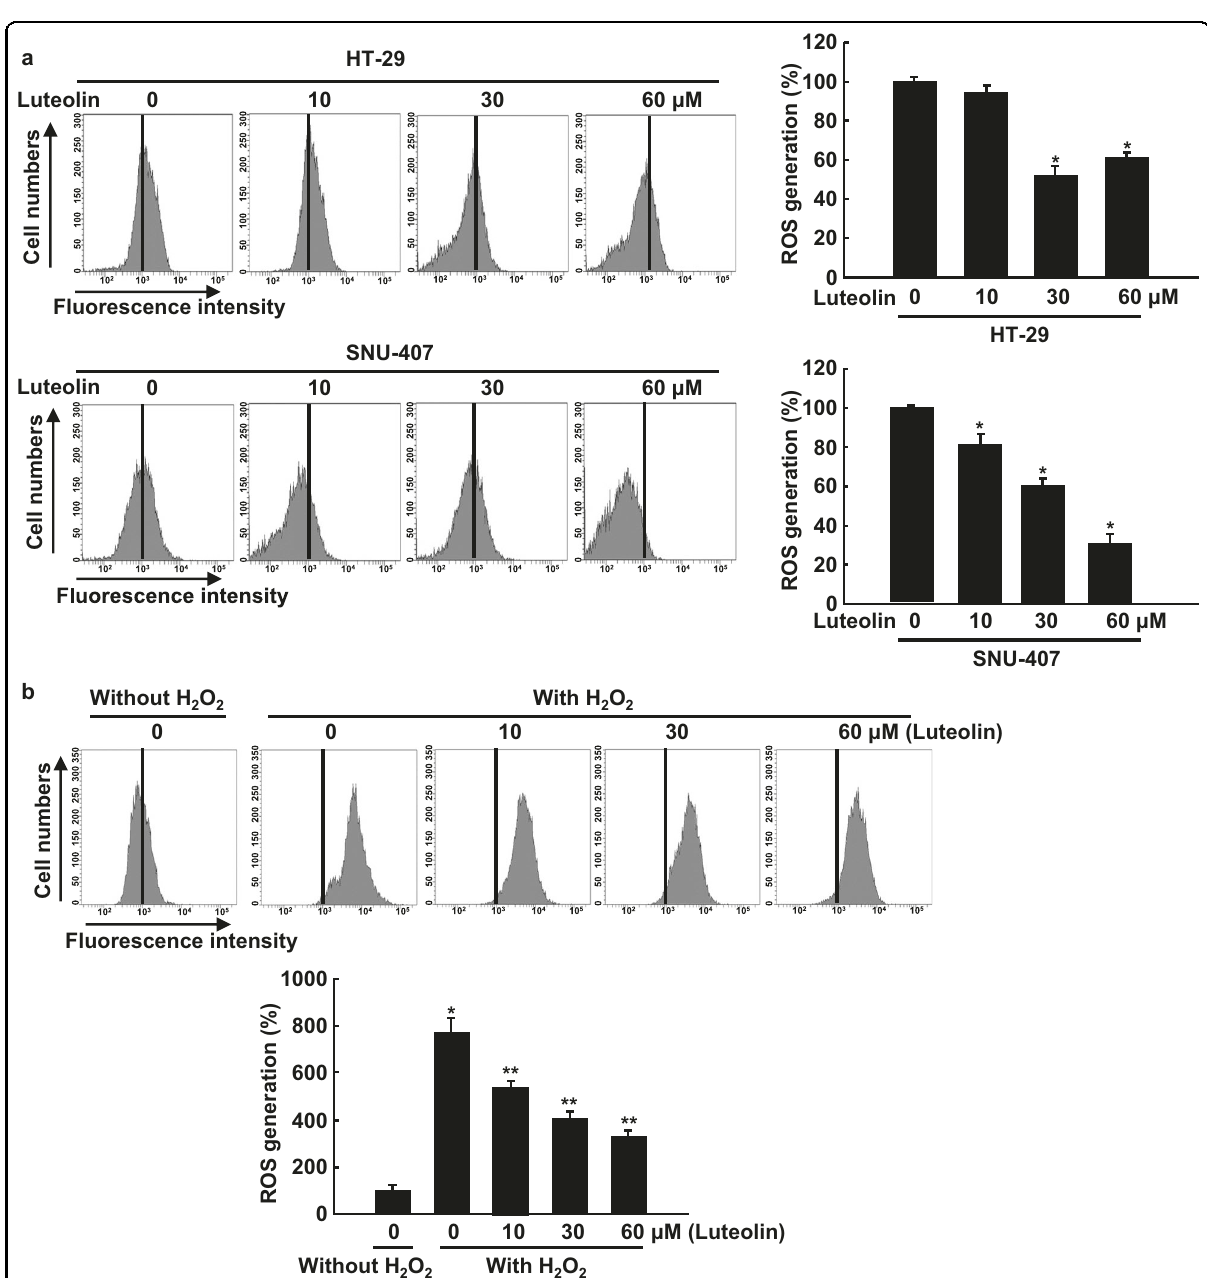
Fig. 2 Luteolin promotes ROS scavenging in colon cancer cells by increasing the expression of antioxidant enzymes. a Cells were treated with various concentrations (0 – 60 μ M) of luteolin for 24 h, and intracellular ROS were detected using fl ow cytometry after DCF-DA staining; * p < 0.05 compared with control cells. b Cells were pre-treated with various concentrations (0 – 60 μ M) of luteolin for 1 h followed by 80 μ M H 2 O 2 for 24 h. Intracellular ROS were detected using fl ow cytometry after DCF-DA staining; * p < 0.05 compared with control cells; ** p < 0.05 compared with H 2 O 2 - treated cells. Cells were treated with c , e various concentrations (0 – 60 μ M) of luteolin for 48 h or d , f 30 μ M luteolin for various durations. Western blot analysis was performed using antibodies against GCLc, GSS, catalase, HO-1, Nrf2, and phospho-Nrf2. g Cells were treated with 80 μ M H 2 O 2 for 24 h followed by 30 μ M luteolin for 48 h, and western blot analysis was performed using antibodies against GCLc, GSS, catalase, and